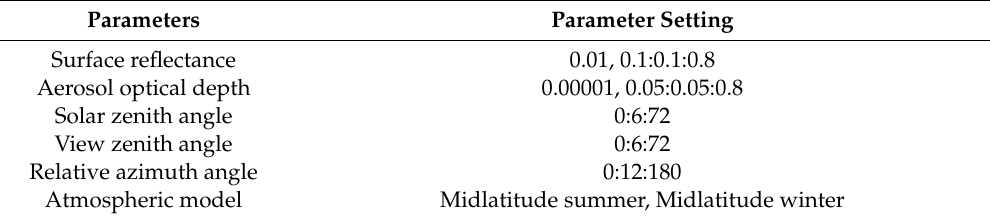
Table 3. Surface, atmospheric, and geometric parameters used for the simulation.